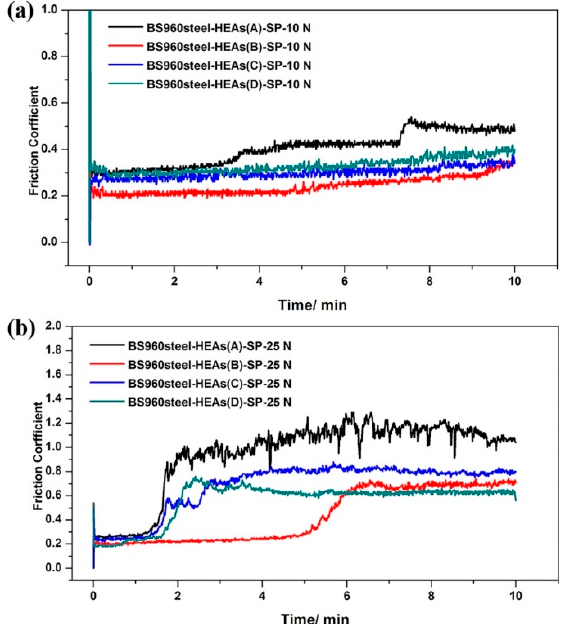
Figure 10. Friction coefficients of FeCoNiCrMo 0.2 high entropy alloy coating sprayed by plasma with different currents after shot peening treatment ( a ) 10 N, ( b ) 25 N.